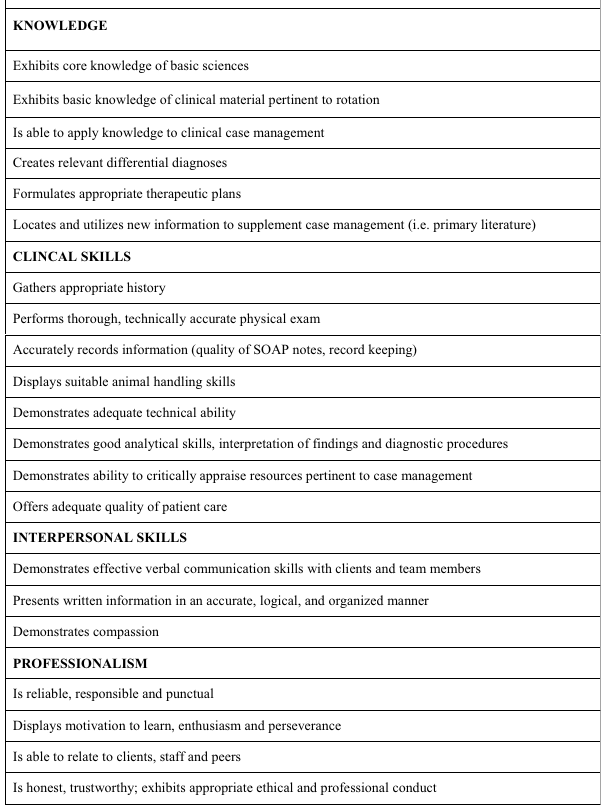
FIGURE 1 | Western University of Health Sciences ITER used during 4th year clinical rotations.